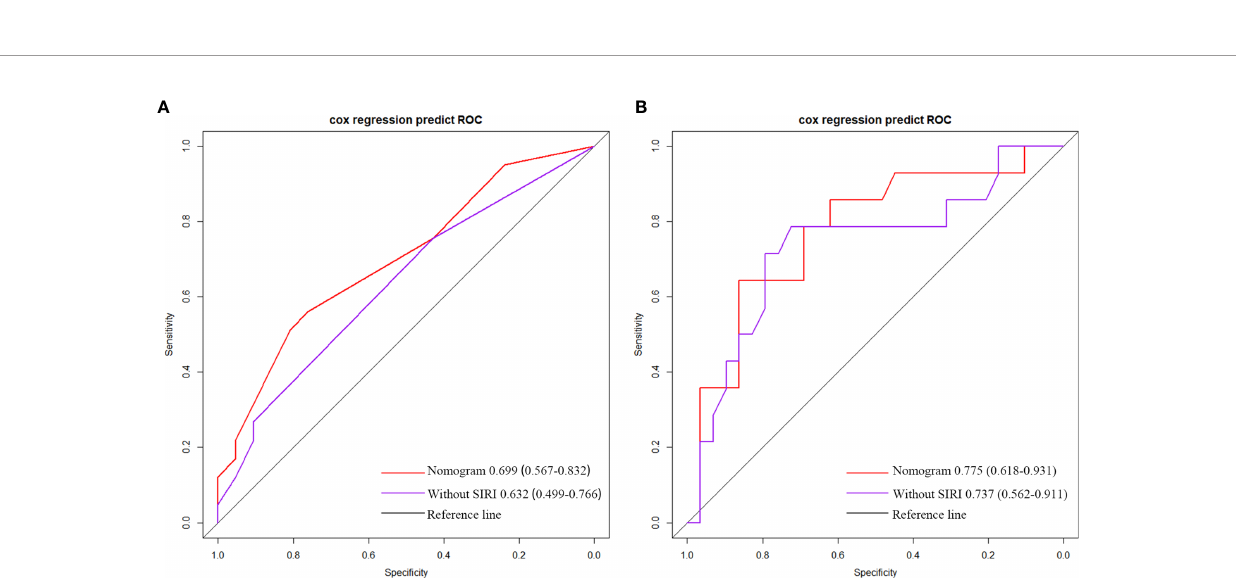
FIGURE 6 | The roc analysis of the prediction prognosis ability of nomogram and predictive factors without SIRI in (A) grade IV and (B) grade III glioma